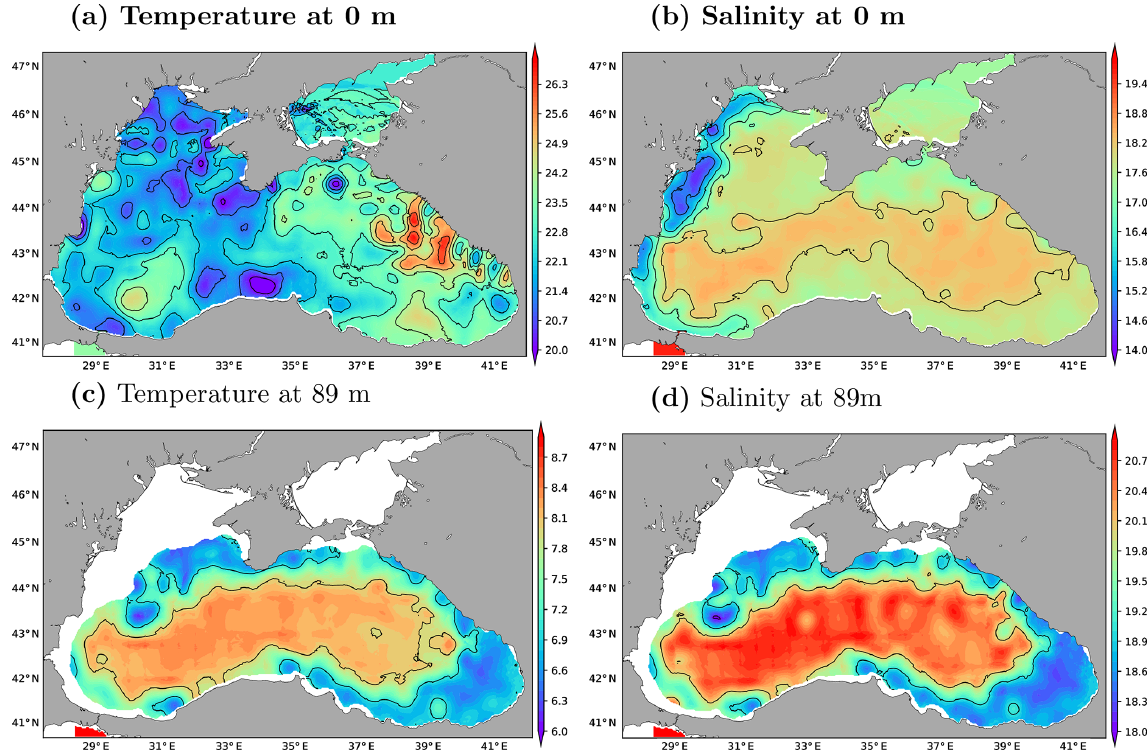
Figure 5. Model initial conditions of temperature (lhs) and salinity (rhs) at the surface (a, b) and at a depth of 89m (c, d) , based on the objective analyses of data from a total of 394 CTD measurement stations obtained during the July 1992 CoMSBlack